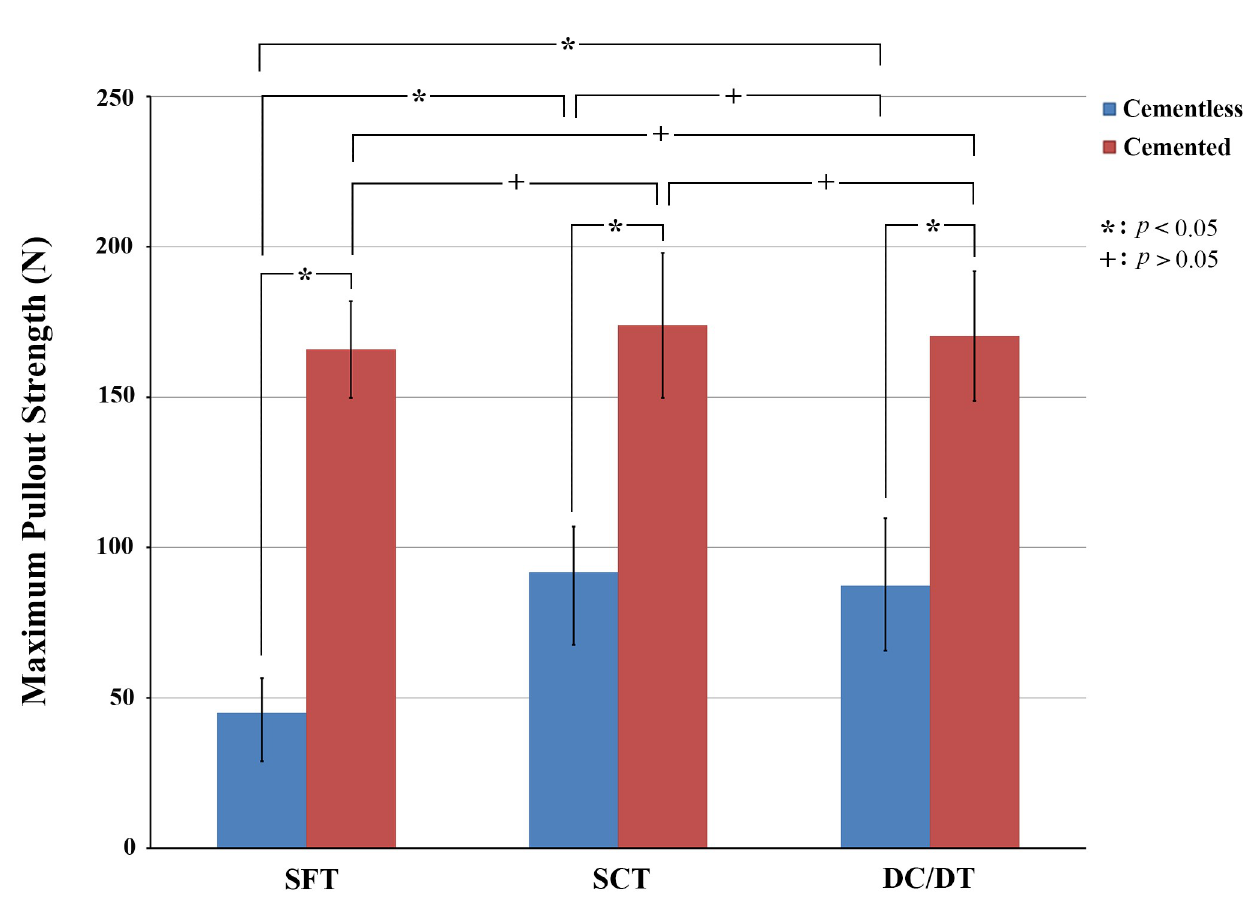
Fig 6. Mean maximal pullout strengths in three groups of test blocks instrumented with cannulated cylindrical screws with and without cement augmentation. The strength was significantly higher with than without cement augmentation ( p < 0.05). However, no significant difference was found among cemented screws with the SFT, SCT, and DC/DT thread profiles ( p > 0.05), suggesting that the thread profile has little impact on the screw fixation strength of pedicle screws fixed with cement in osteoporotic bone.